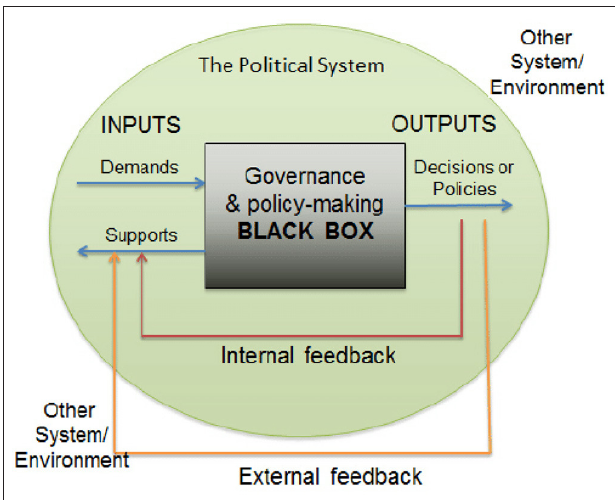
FIGURE 1 | Analysis of Political System (David Easton, A Systems Analysis of Political Life, 1965). Source: researchgate.com.